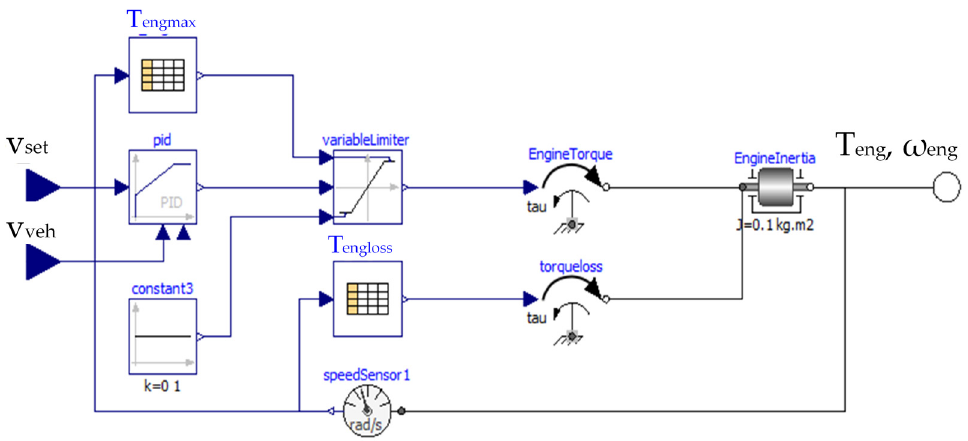
Figure 3. Diagram of the “engine” module in the developed test simulation.